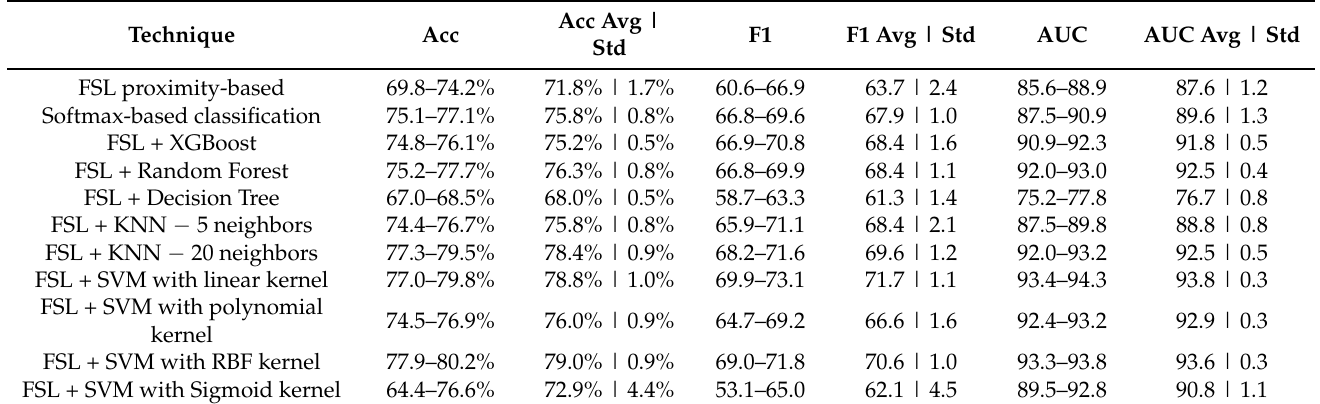
Table 4. Results for five-class classification, part I.